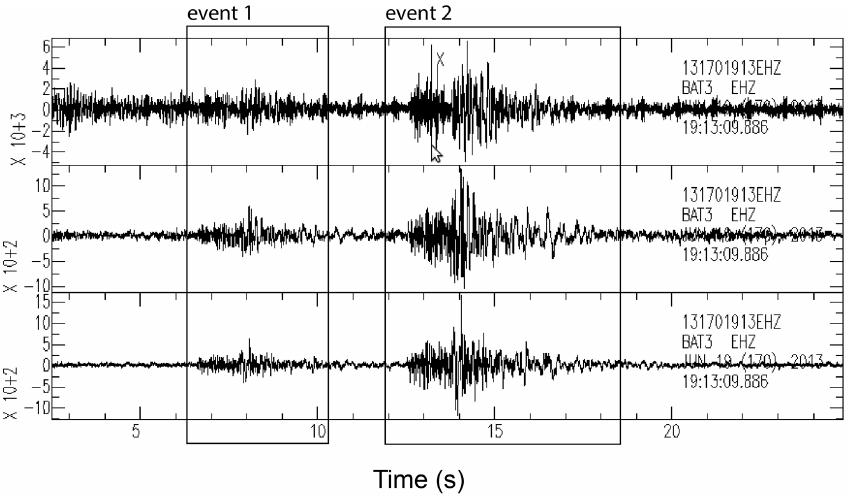
Figure 5. Two small earthquakes recorded at BAT3. Top trace: surface sensor. Middle trace: sensor at 150m. Bottom trace: bottom sensor